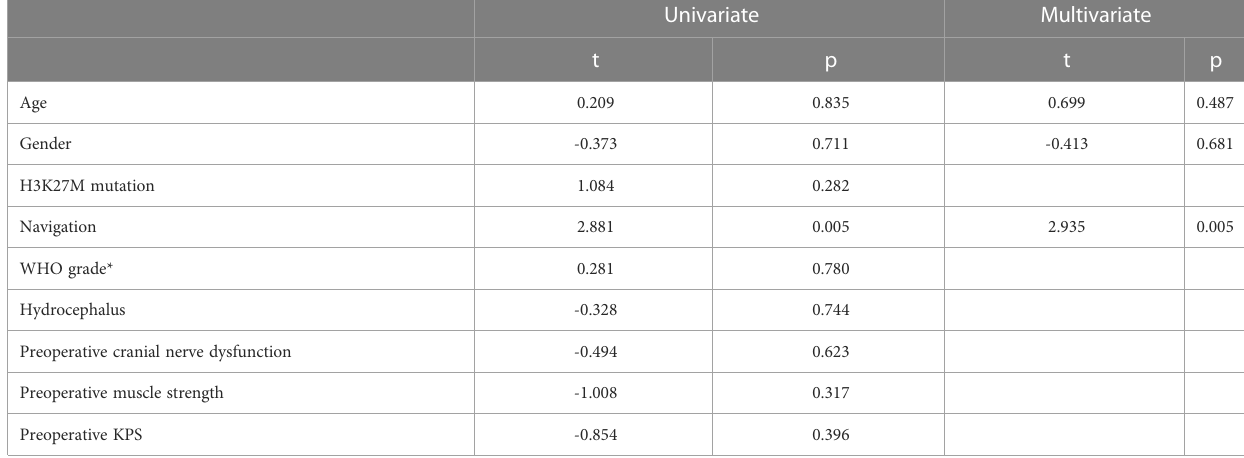
TABLE 3 Univariate and multivariate leaner regression showing the usage of NN is an independent factor for the extent of resection in the DIPG patients.